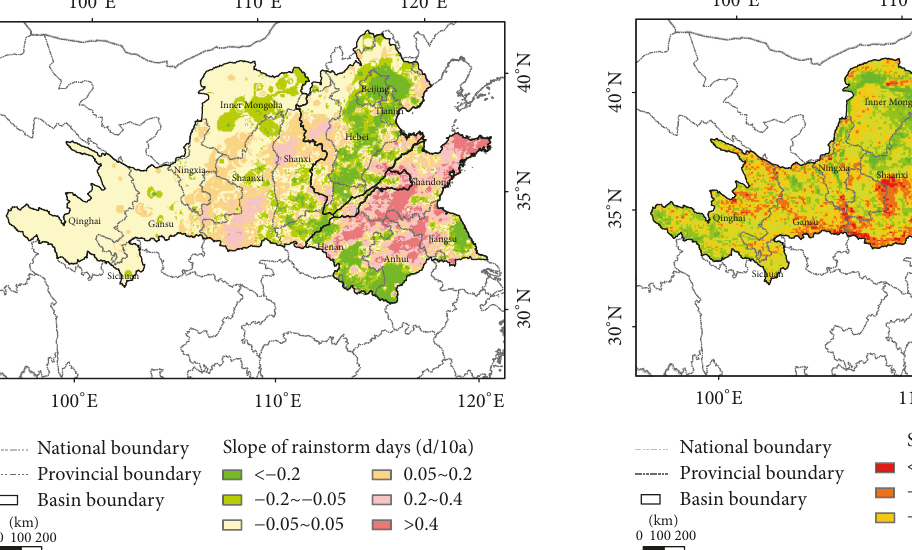
Figure 10: Rate of change in NDVI from 1982 to 2011.